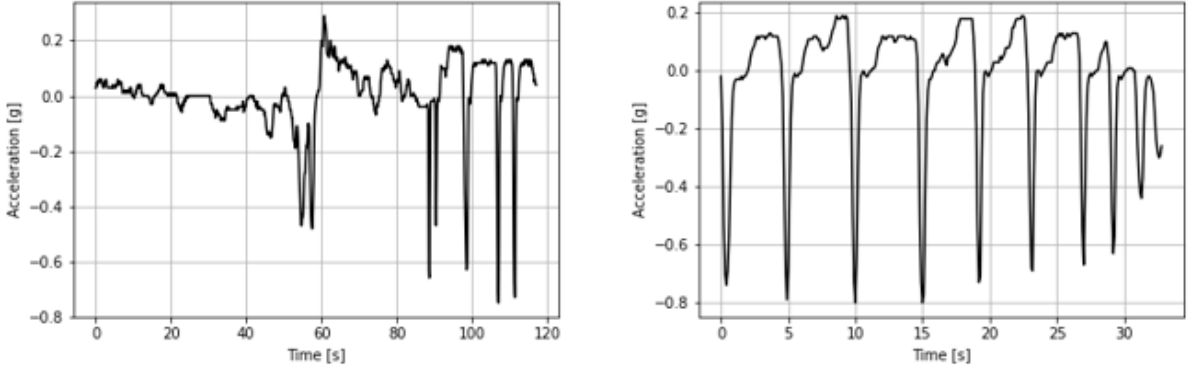
Figure A2. The variations in the vehicle’s acceleration in the hard brake scenario.